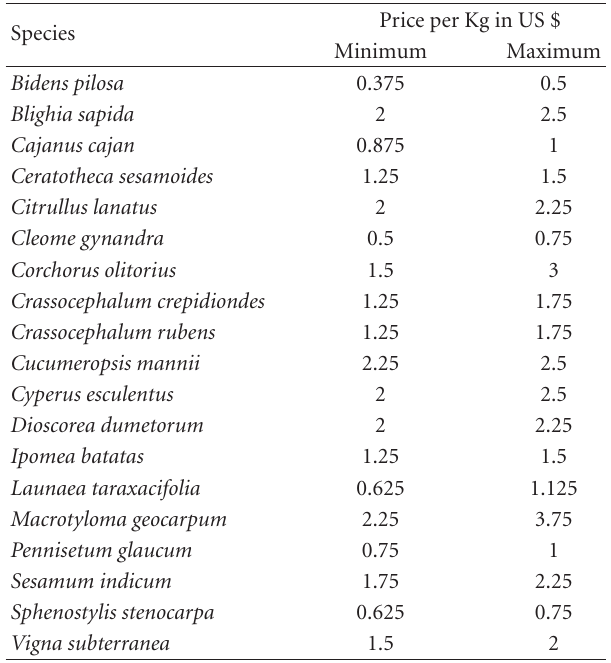
Table 6: Market value of the priority NUS at Glazou´e market as indicated by the market’s women